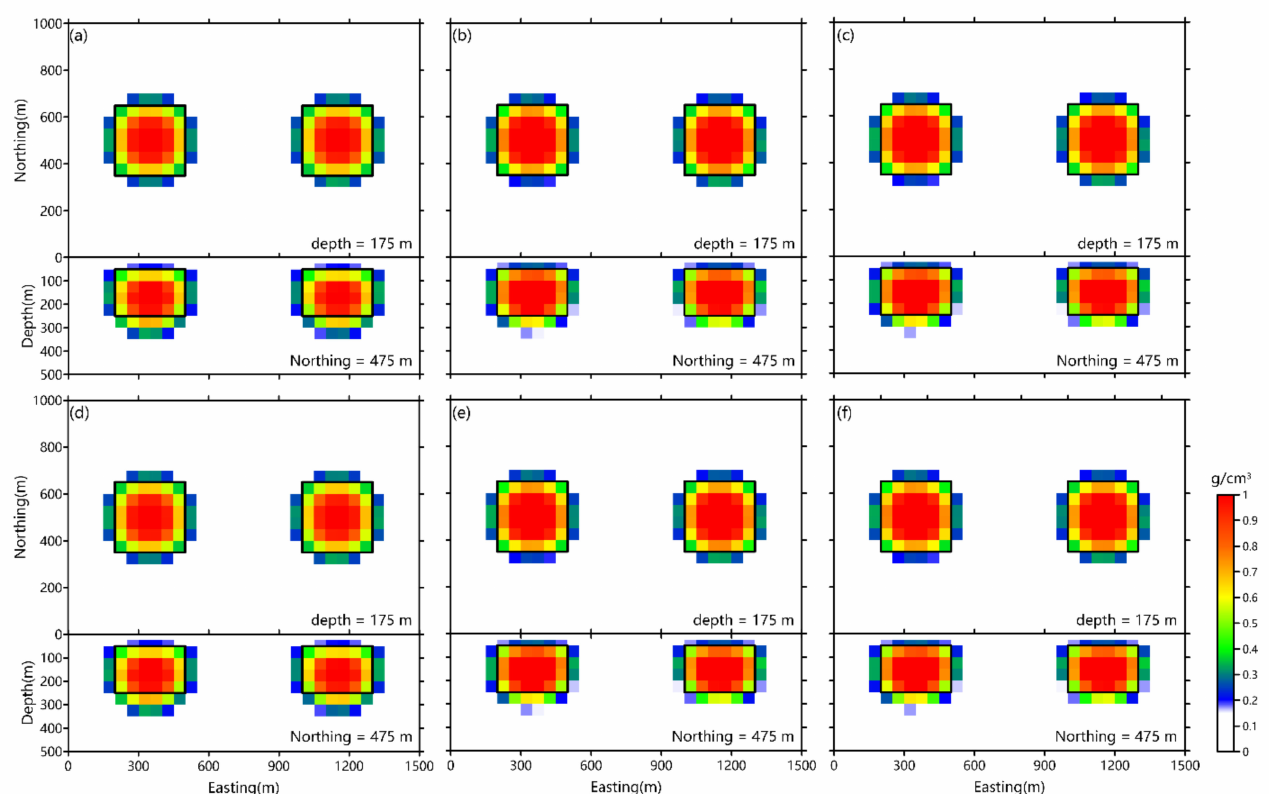
Figure 2. Inversion results from different regularization methods. The generalized cross-validation (GCV) methods using ( a ) the conjugate gradient (CG) method, ( b ) the generalized singular value decomposition (GSVD), and ( c ) the randomized generalized singular value decomposition (RGSVD algorithm; the unbiased predictive risk estimator (UPRE) methods using ( d ) the CG method, ( e ) the GSVD, and ( f ) the RGSVD algorithm. In all these panels, the black lines indicate the real position of the model.